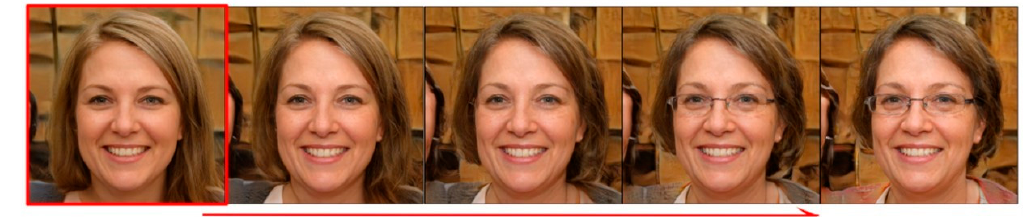
Figure 6. Entanglement of glasses attributes and age attributes in face